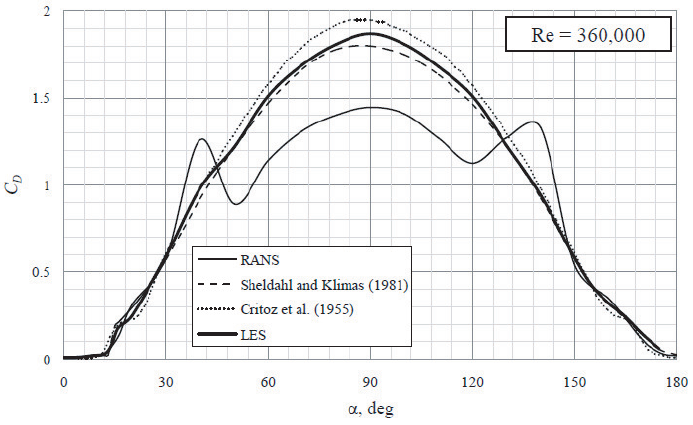
Figure 17. Drag as a function of AOA at Re = 3.6 × 10 5 .